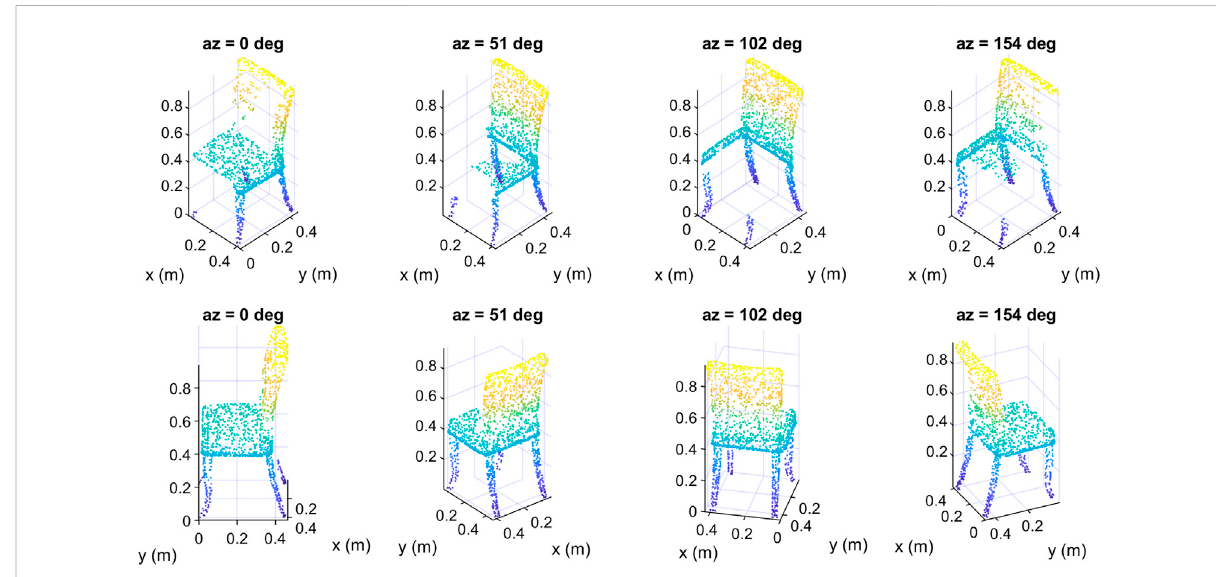
FIGURE 10 Some data samples of the class “ chair ” of the created dataset at different azimuth angles: top) fi xed viewpoint, down) camera ’ s viewpoint.